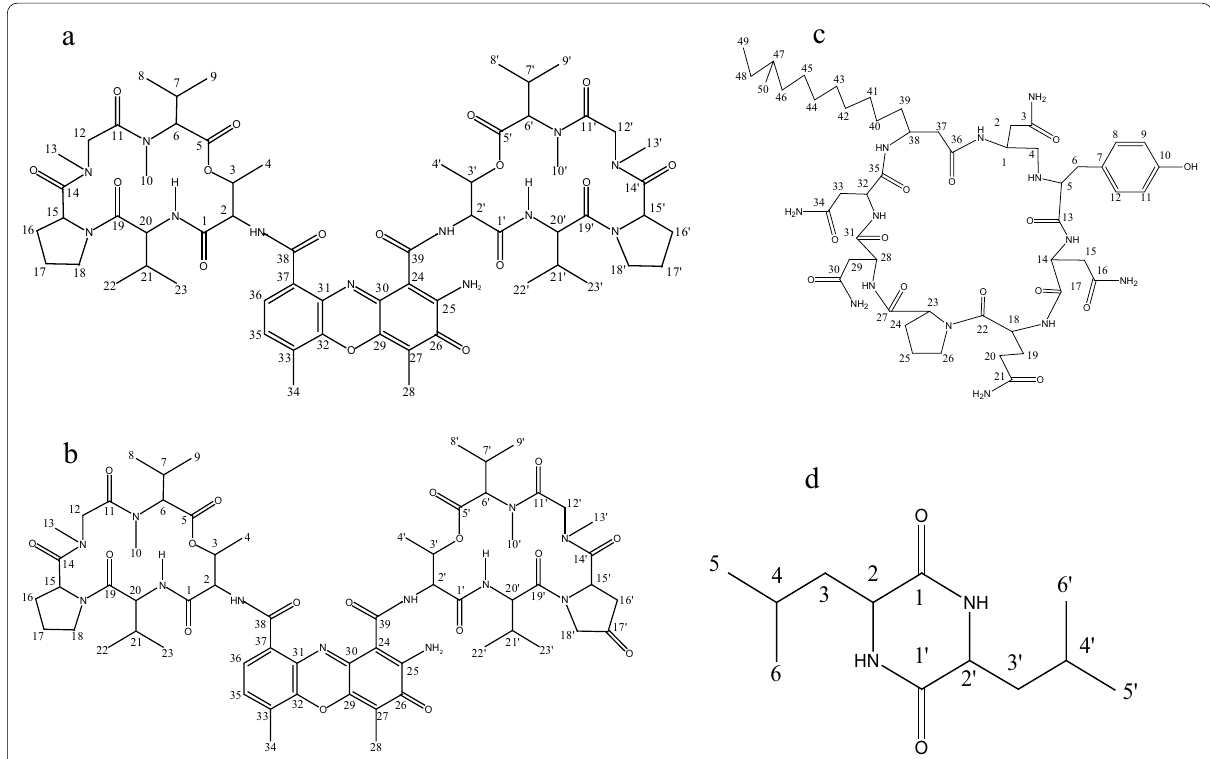
Fig. 3 Molecular Structure of compound 1–4 a compound 1: Actinomycin D. b compound 2: Actinomycin X 2. c Compound 3: Mojavensin A. d compound 4: cyclic (leucine-leucine)